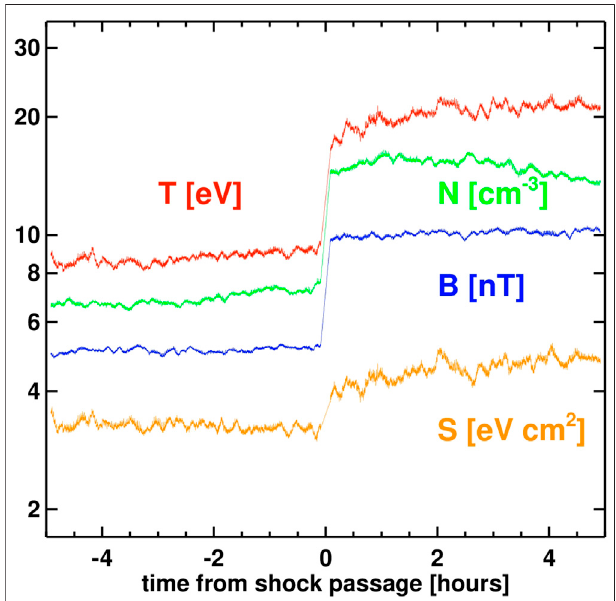
FIGURE 10 | A superposed epoch analysis of 140 fast forward IP shocks analyzed in [105]. The plot shows average pro fi les of proton temperature (red), proton number density (green), magnetic fi eld magnitude (blue) and speci fi c entropy (orange) for 5 h of upstream/downstream plasma. Note that the statistical set is reduced from the original set of 174 IP shocks due to additional requirements on the temperature